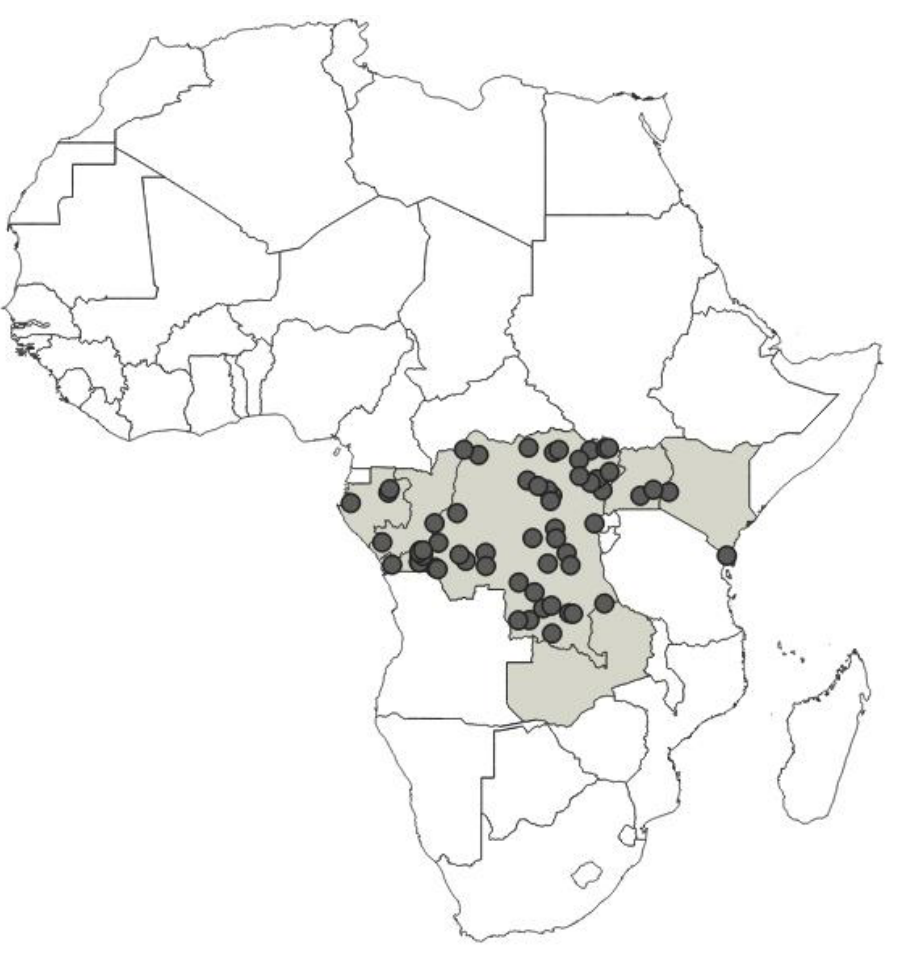
Figure 39. Known distribution of Phonoctonus fairmairei Villiers, 1948.